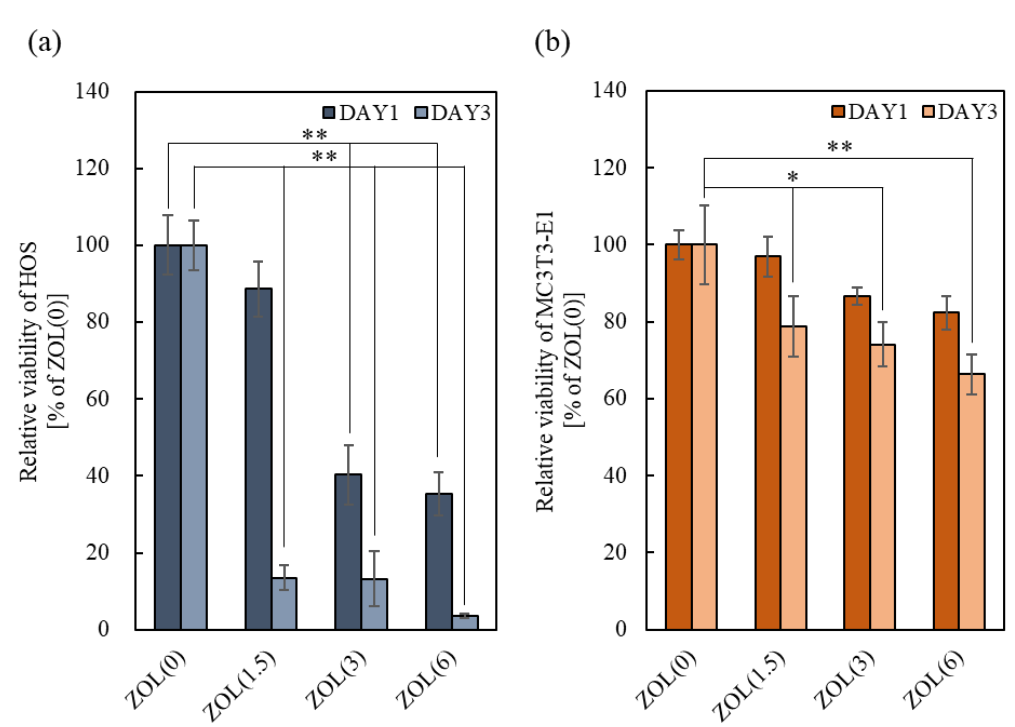
Figure 4. Effect of bound-ZOL on cell viability of tumor cells and osteoblasts. HOS and MC3T3-E1were cultured on each ZOL/β-TCP disc for three days. After culturing, the relative viability of ( a ) HOS and ( b ) MC3T3-E1 was determined by MTT assay. Error bars indicate standard deviation of the mean. The asterisks show * p < 0.05 and ** p < 0.01 as compared with ZOL(0) by Student’s t -test.